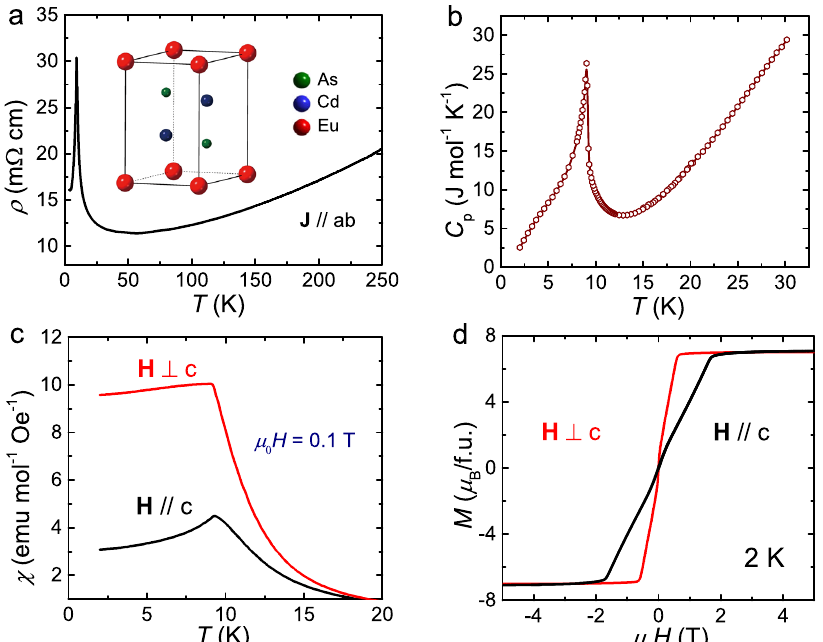
Fig. 1 Physical properties of EuCd 2 As 2 at ambient pressure. a Temperature dependence of the resistivity ρ ( T ) in the ab -plane. The primitive unit cell is shown in the inset, with Eu 2 + ions forming a triangular lattice in the ab -plane 25 . b Total speci fi c heat C p ( T ). c Magnetic susceptibility = 0.1 T. d The fi eld-dependence of the magnetization M ( H ), measured for two fi eld directions at 2 K χ ( T ), measured in an applied fi eld of μ 0 H after zero- fi eld